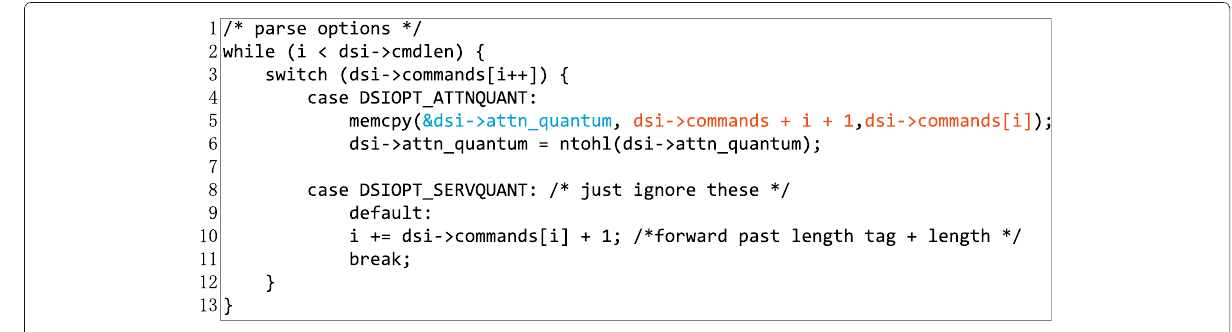
Fig. 13 Netatalk vulnerable code